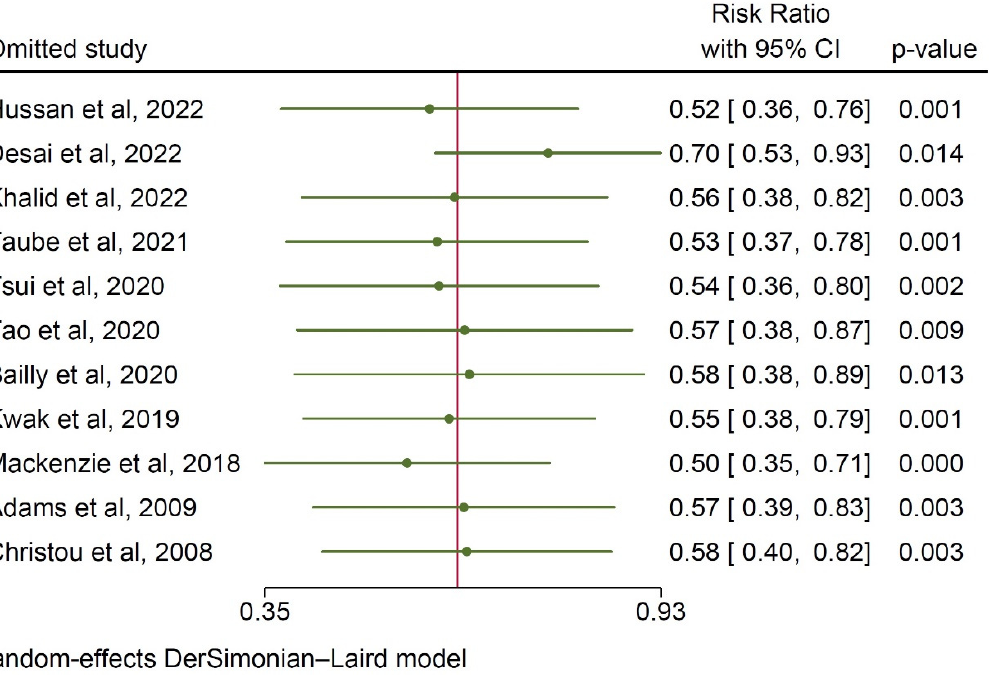
Figure 4. Leave-one-out sensitivity analysis on the incidence rates for colorectal cancer [9,10,12–20].